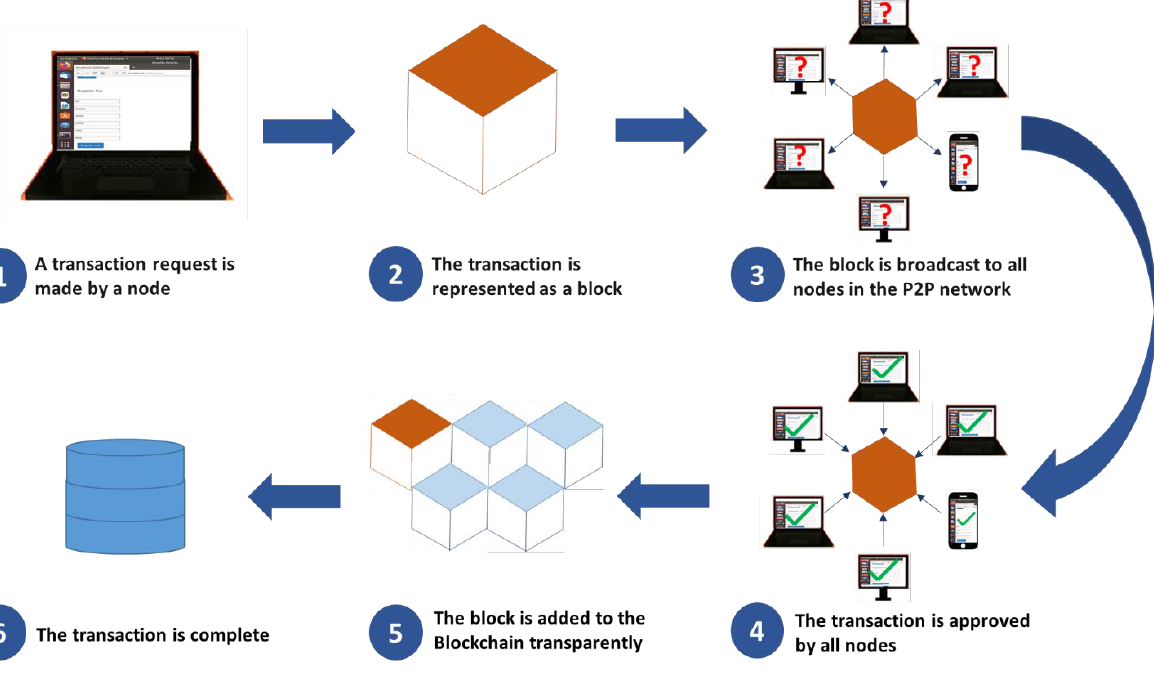
Figure 3. How blockchain